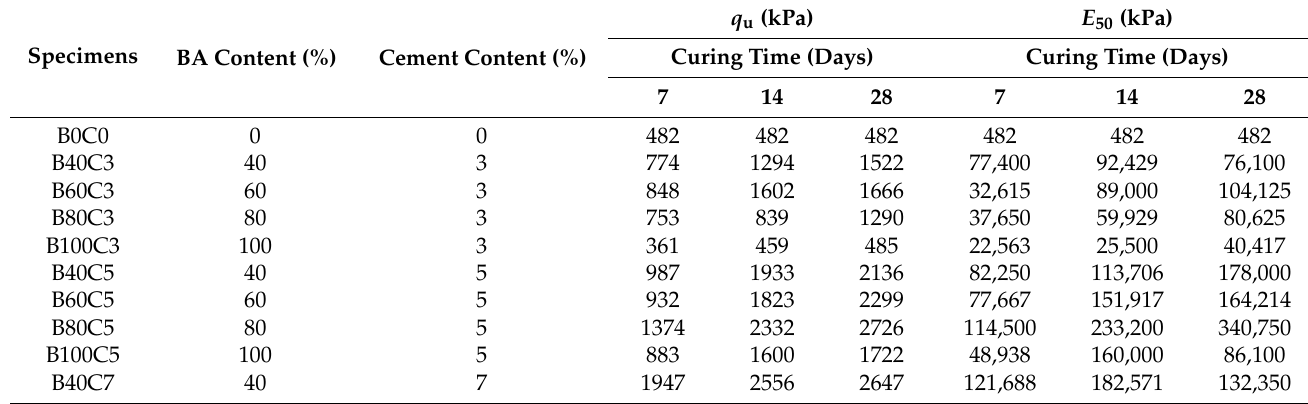
Figure 7. The q u of CSS specimens for different BA and cement contents at 7 days of curing time.